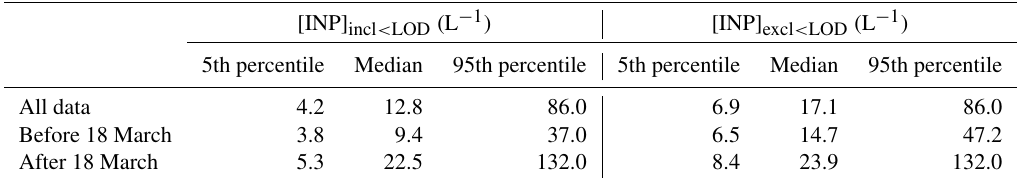
Table 1. Median, 5th and 95th percentile values of the INP number concentration calculated by including or excluding values below the